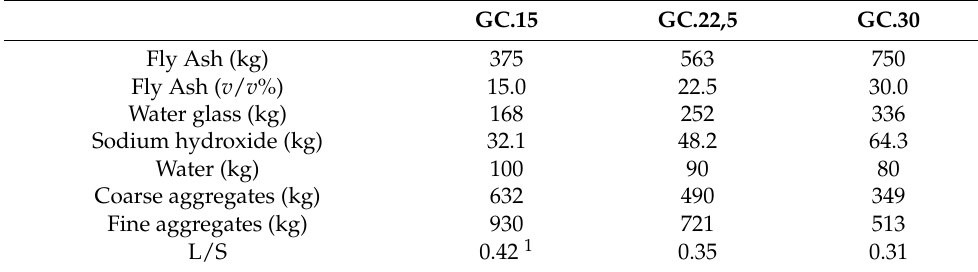
Table 2. Composition of GC mix (per 1 m 3 of